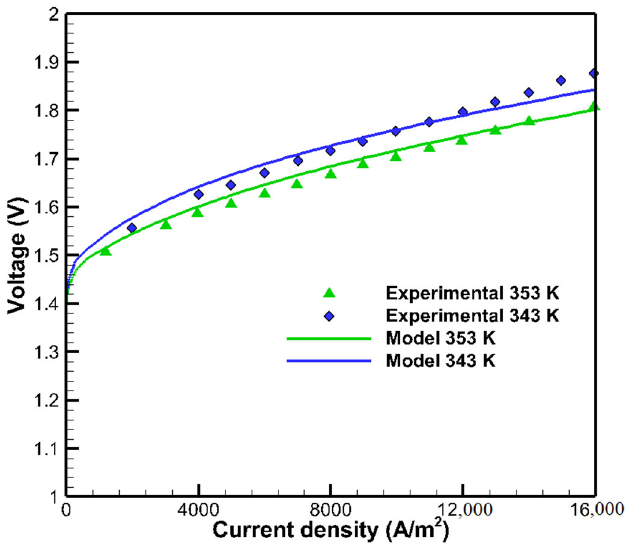
Figure 3. Comparison of polarization curve between experimental data developed from [56] and the present